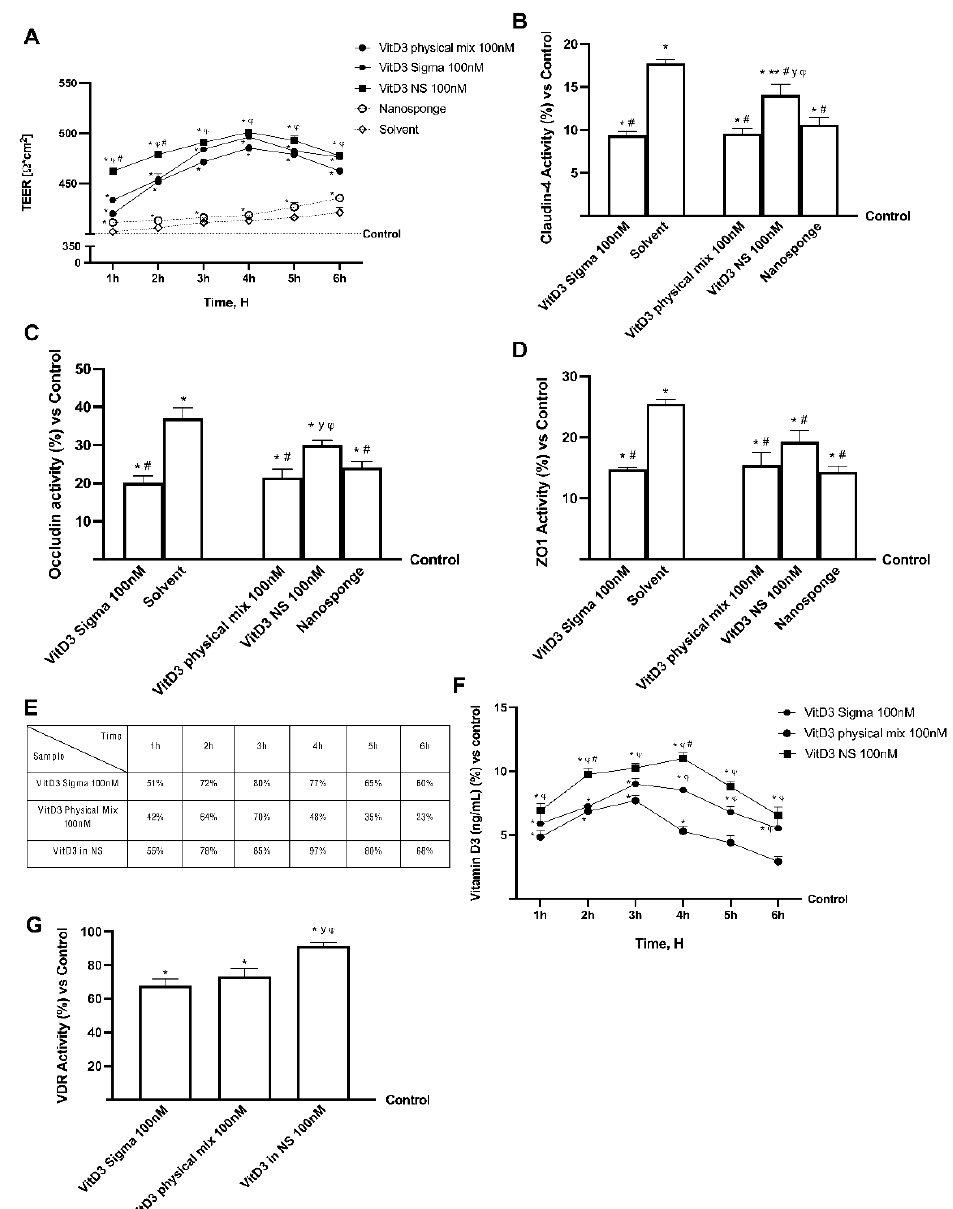
Figure 3. Permeability study on CaCo-2 cells. In ( A ) TEER (transepithelial electrical resistance) Value using EVOM3; from ( B – D ) the analysis of TJ measured by Enzyme-Linked Immunosorbent Assay (ELISA) test (Occludin, Claudin1, and ZO-1 (Zona occludens 1), respectively); in ( E ) the Papp (Apparent Permeability Coefficient) values in which data < 0.2 × 10 −6 cm/s mean very poor absorp- tion with a bioavailability < 1%, data between 0.2 × 10 −6 and 2 × 10 −6 cm/s with bioavailability between 1 and 90%, and data > 2 × 10 −6 cm/s mean very good absorption with a bioavailability over 90%. In ( F ) VitD3 quantification measured by ELISA kit. In ( G ) Vitamin D3 Receptor activity measured by ELISA kit. Data are mean ± SD of five independent experiments performed in triplicates. From ( B – D ) means ± SD are expressed comparing data to control value (0% line) and all molecules result * p < 0.05 vs. control; ** p < 0.05 vs. nanosponge; # vs. solvent; y vs. VitD3 Physical Mix 100 nM; φ vs. VitD3 Sigma 100 nM. On the contrary, in ( A , E , F ), the control samples are specifically reported and VitD3 NS 100 nM, VitD3 Physical Mix 100 nM and VitD3 Sigma 100 nM are p < 0.05 vs. control. In conclusion, in (G) means ± SD are expressed comparing data to control value (0% line) and all mol- ecules result * p < 0.05 vs. control; φ p < 0.05 vs. VitD3 physical mix 100 nM; # p < 0.05 vs. VitD3 sigma.